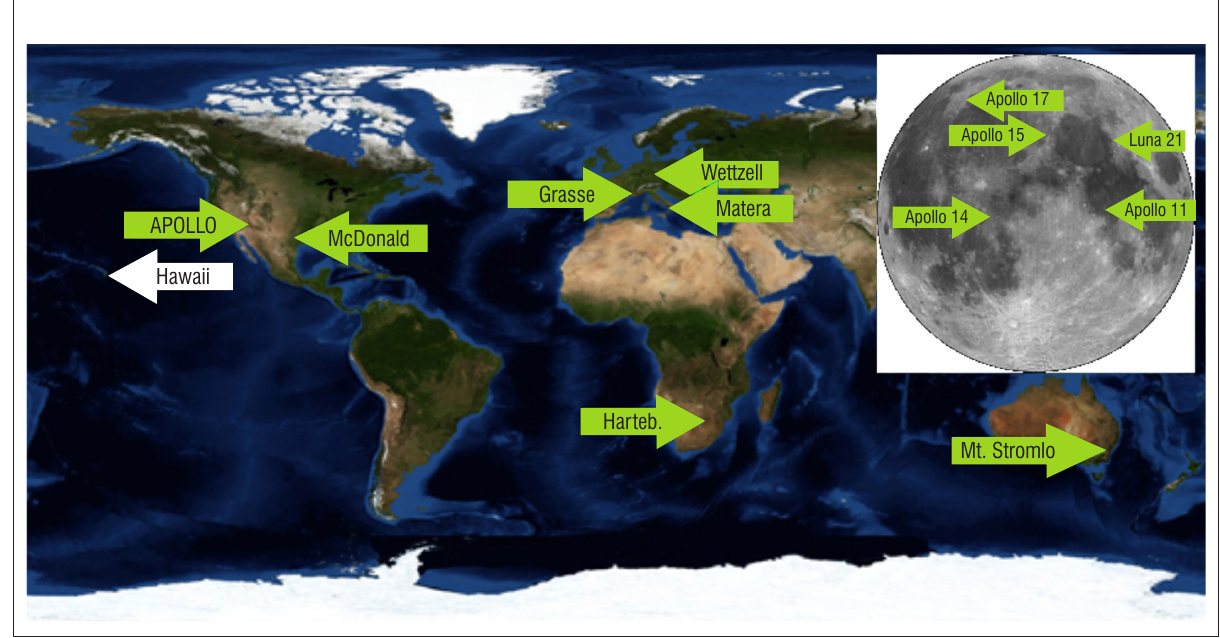
Figure 2 : Distribution of the International Laser Ranging Service network of lunar laser ranging stations. The inset map illustrates the location of the retroreflectors on the surface of the